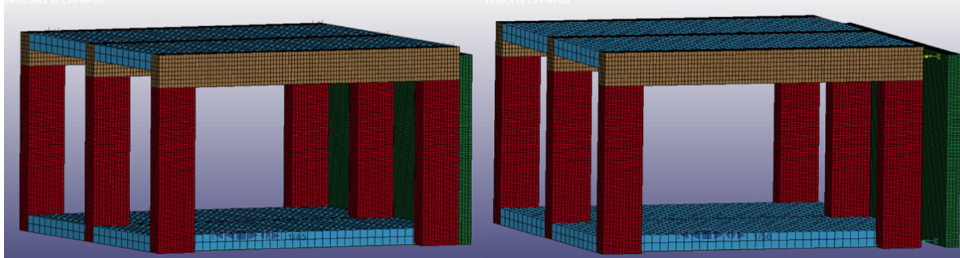
Figure 18. Building structure with central column used to simulate an almost contact explosive charge.